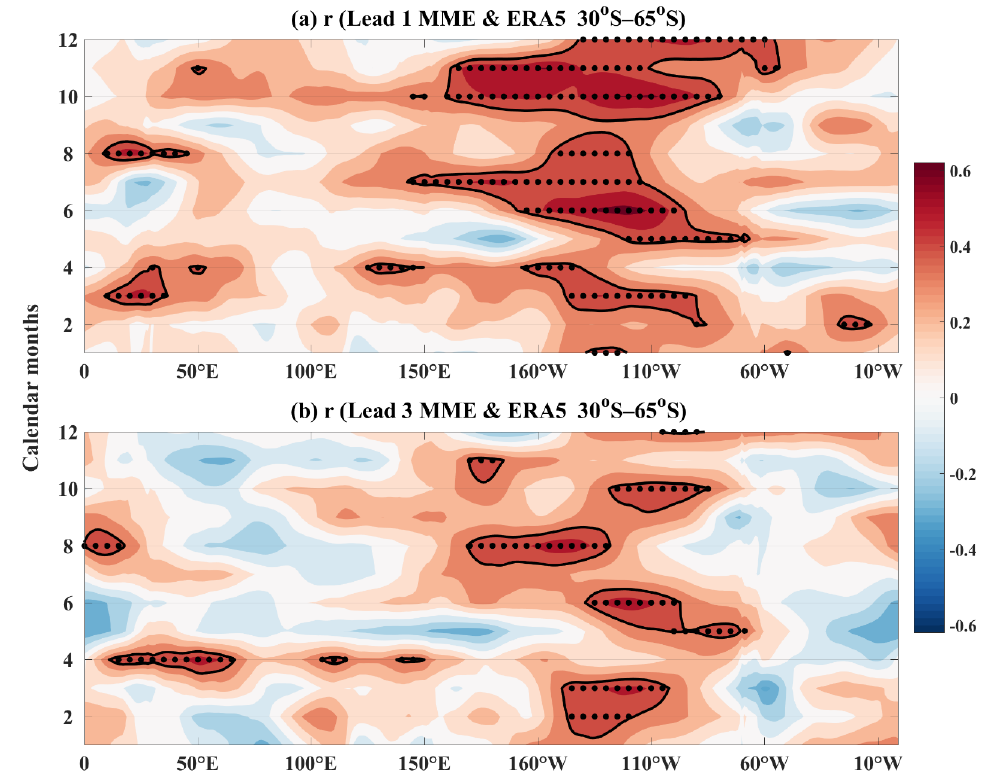
Figure 9. Correlation between the seasonal prediction results and the ERA5 reanalysis for the sea- level pressure differences between 30° S and 65° S with (a) a 1-month and (b) 3-month lead for 12 targeted months. The black contours indicate the 0.4 isoline indicating statistical significance at the 95% level, the black dots indicate that the sign of correlation results between the two seasonal pre- diction systems and the ERA5 reanalysis data are consistent.